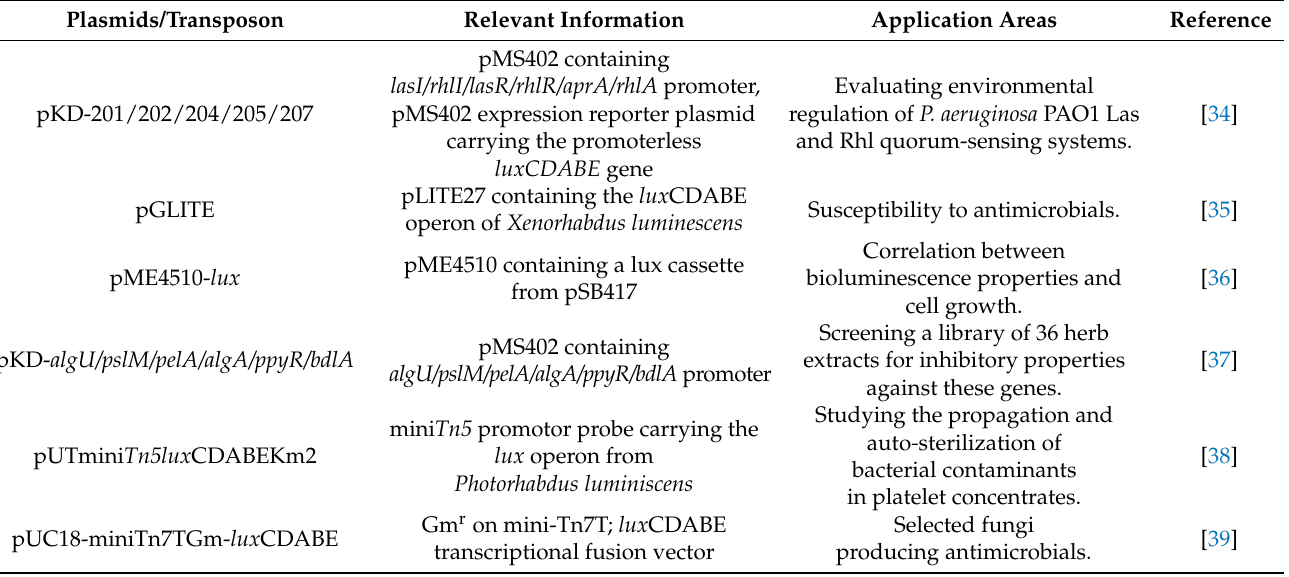
Table 3. Summary of lux-tagged P. aeruginosa that have been presented in recent studies. Plasmids/Transposon Relevant Information Application Areas Reference pMS402 containing lasI/rhlI/lasR/rhlR/aprA/rhlA promoter, Evaluating environmental pKD-201/202/204/205/207 regulation of P. aeruginosa PAO1 Las pMS402 expression reporter plasmid and Rhl quorum-sensing systems. carrying the promoterless luxCDABE gene pLITE27 containing the lux CDABE pGLITE Susceptibility to antimicrobials. operon of Xenorhabdus luminescens Correlation between pME4510 containing a lux cassette pME4510- lux bioluminescence properties and from pSB417 cell growth. Screening a library of 36 herb pMS402 containing pKD- algU/pslM/pelA/algA/ppyR/bdlA extracts for inhibitory properties algU/pslM/pelA/algA/ppyR/bdlA promoter against these genes. Studying the propagation and mini Tn5 promotor probe carrying the auto - sterilization of lux operon from pUTmini Tn5lux CDABEKm2 bacterial contaminants Photorhabdus luminiscens in platelet concentrates. Gm r on mini-Tn7T; lux CDABE Selected fungi pUC18-miniTn7TGm- lux CDABE transcriptional fusion vector producing